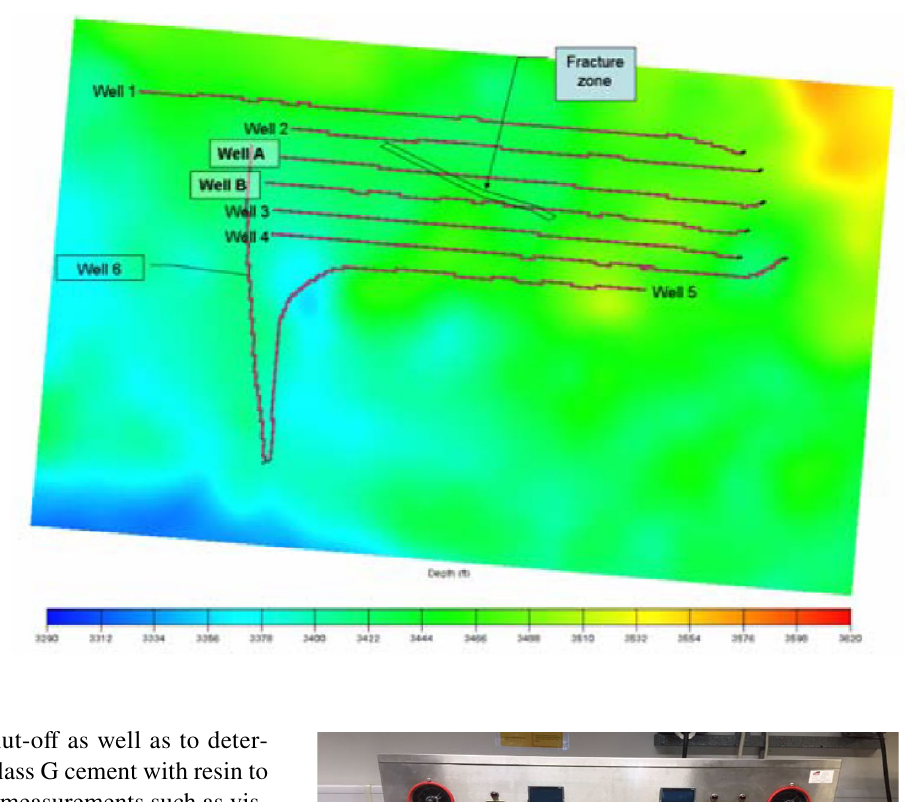
Fig. 4 Top view with wells and fracture zone (Pedersen et al. 2009)